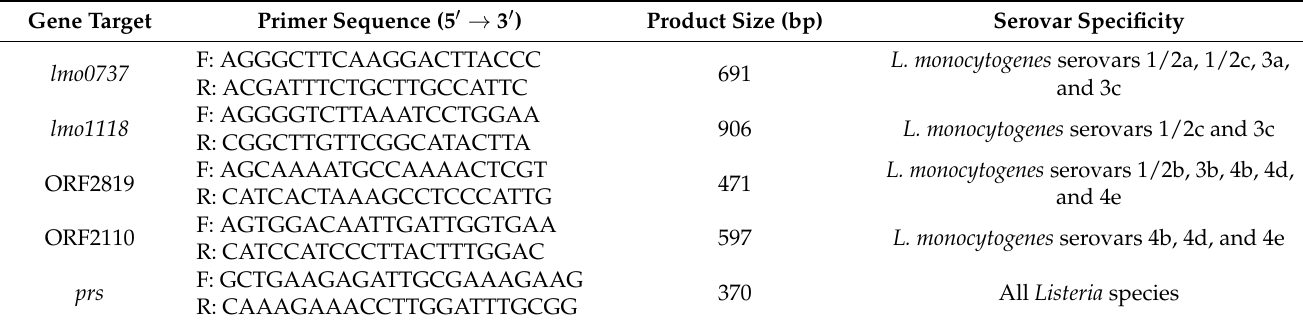
Table 6. Nucleotide sequences of the primer sets used in this study